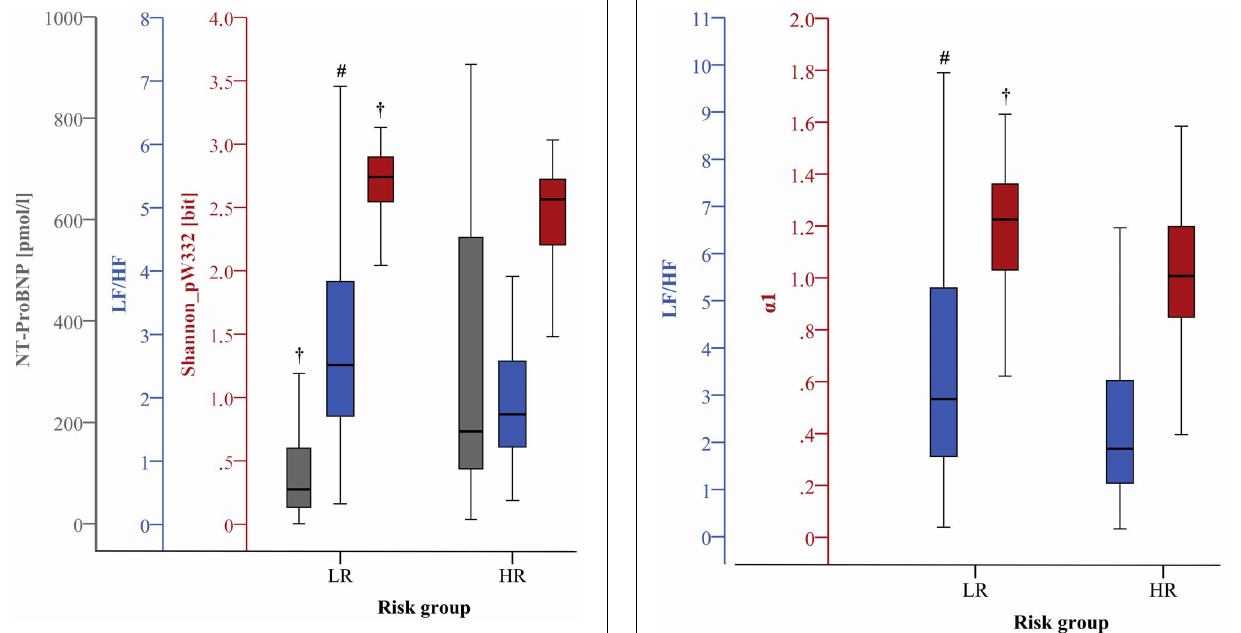
FIGURE 2 | Boxplots of the most significant univariate linear and nonlinear indices (first 30min) discriminating low (LR) and high (HR) risk groups ( # p < 0 . 01; † p < 0 . 001). The clinical index is the same as in Figure 1